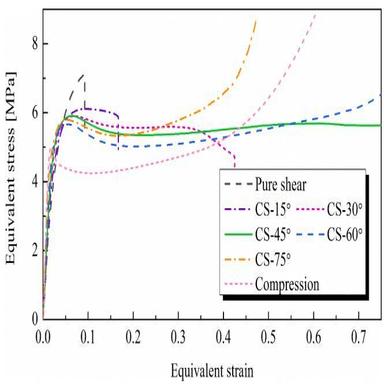
The equivalent stress-strain responses of PMI foam materials with density of 0.205 g/cm3 under combined compression-shear tests. With the increase of loading angle, the fracture of the PMI foam material gradually disappears; and the critical fracture angle is observed as 30◦.